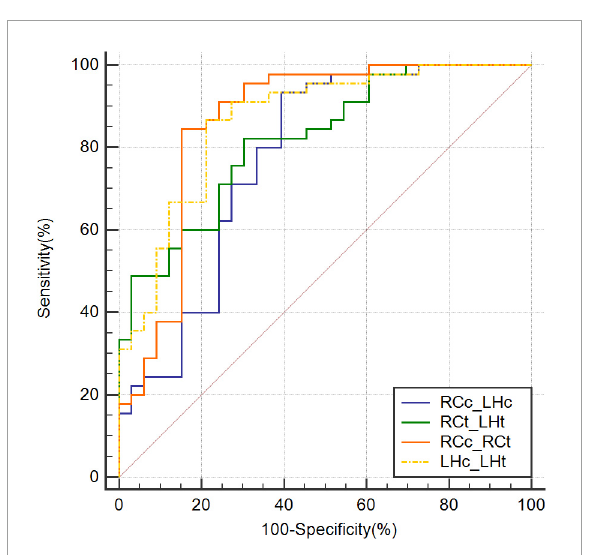
FIGURE4 Receiver operating characteristic curves combining two parameters. CBF, cerebral blood flow; LHc_LHt, CBF of left hippocampus and T1 value of left hippocampus; RCc_LHc, CBF of right caudate nucleus and CBF of left hippocampus; RCc_RCt, CBF of right caudate nucleus and and T1 value of right caudate nucleus; RCt_LHt, T1 value of right caudate nucleus and T1 value of left hippocampus; ROC, receiver operating characteristic.